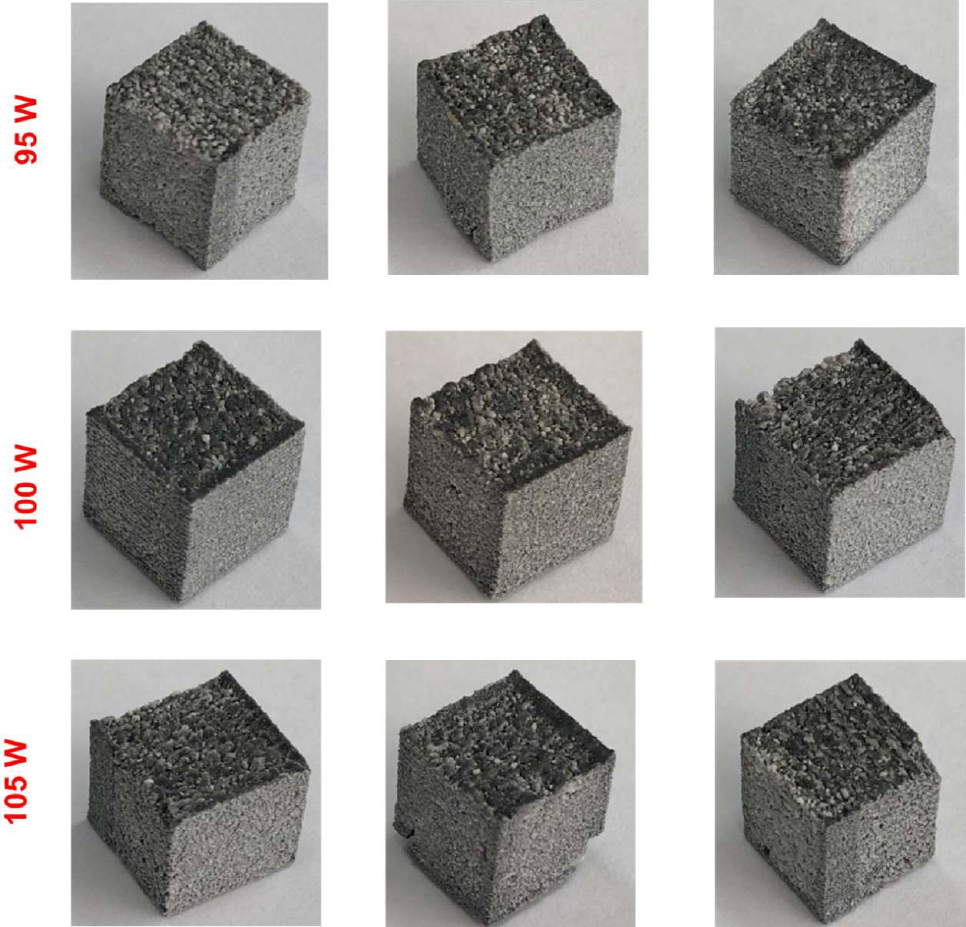
Figure 7. Alumina cubes printed by using the process parameters calculated from the model.